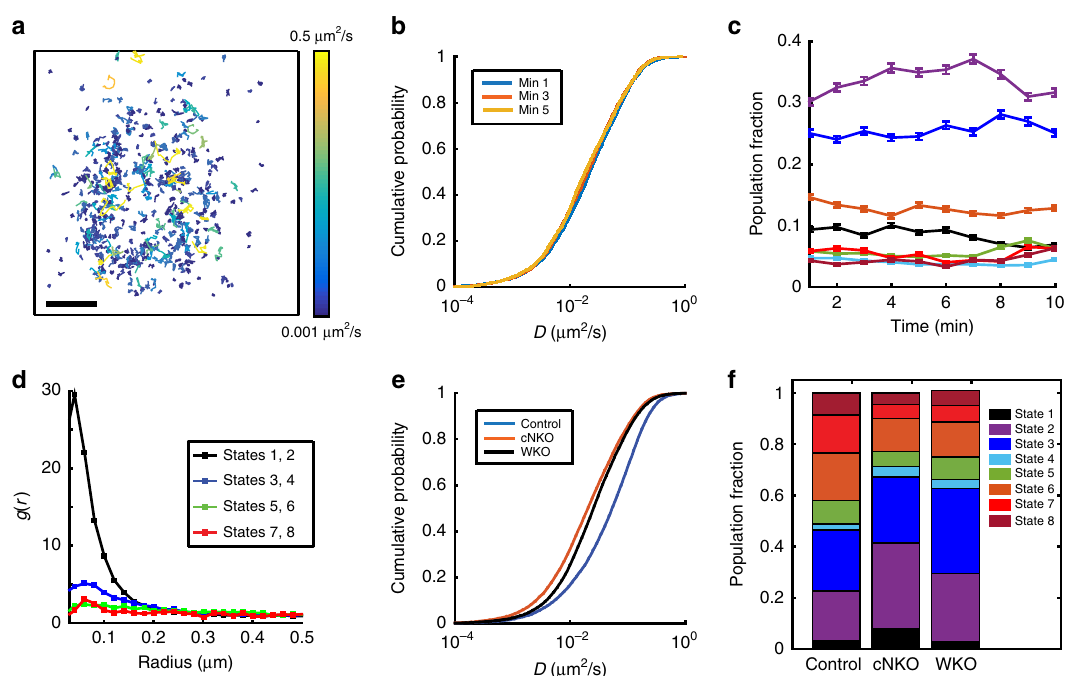
Fig. 4 N-WASP knockout leads to predominance of BCR molecules in lower mobility diffusive states. a Collection of tracks obtained from pEM analysis of BCR molecules in a cNKO cell during a 10-min period. The tracks are color coded for diffusivity. Scale bar is 1 μ m. b Cumulative distribution function for diffusivities measured at 1, 3, and 5 min after BCR stimulation in B cells from cNKO mice. c Plots of population fractions of eight distinct diffusive states as a function of time for BCR in cNKO cells. Error bars represent a con fi dence interval of 95% on the population fraction calculation. The colors corresponding to the different states are as shown in f . d Pair correlation function plots of the trajectories in different diffusive states for cNKO cells. e The distribution of diffusivities from the 5 – 10 min time period after activation, for BCR in control, WKO, and cNKO cells. The distributions for control are signi fi cantly different from WKO and cNKO cells (control cells N = 15, WKO cells N = 21 cells , p < 0.001 and cNKO cells N = 17 , p < 0.0001 Kruskal – Wallis test). f Comparative population fractions for BCR in different states over the entire time period in control, WKO, and cNKO cells. Signi fi cance levels for the differences are in Supplementary Table 1. Source data are provided as a Source Data fi